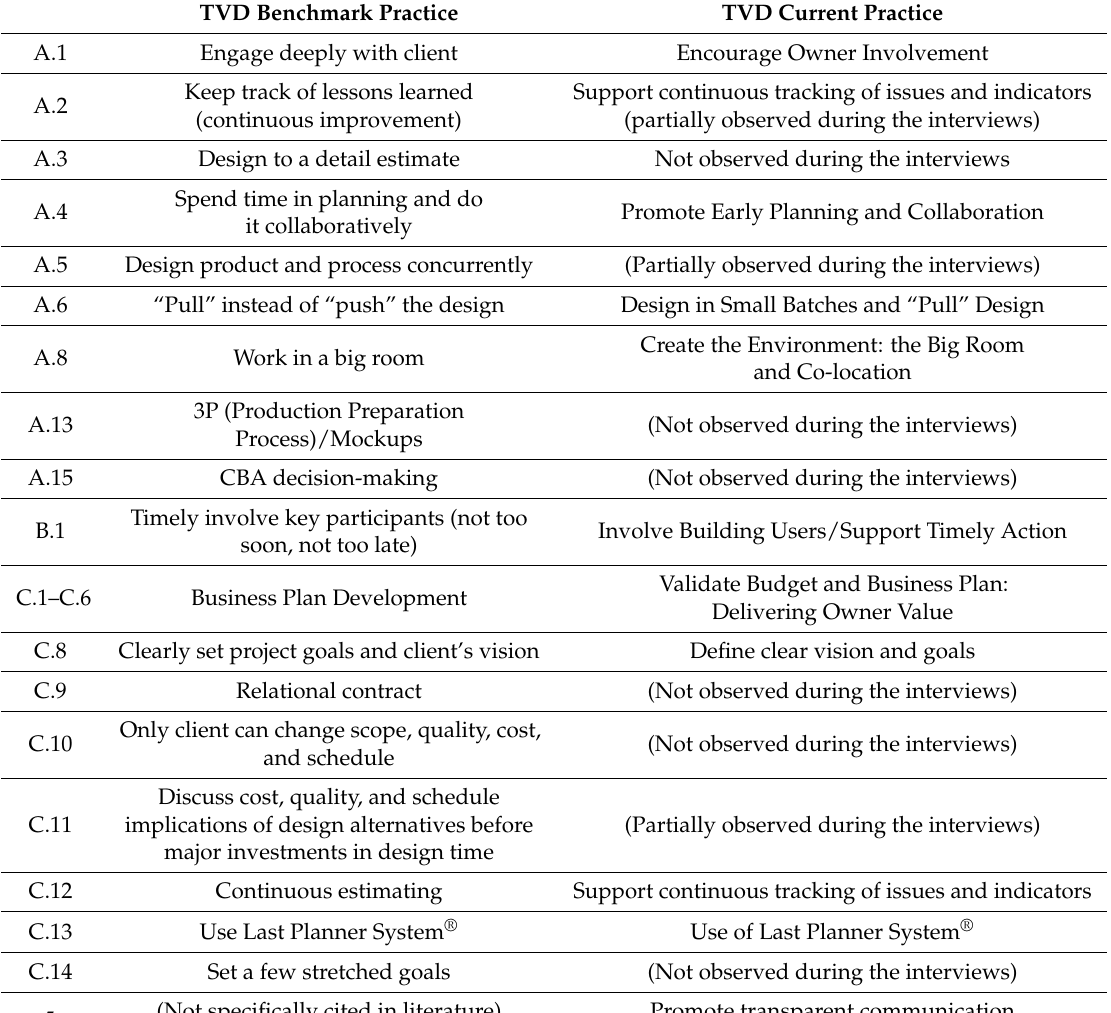
Table 4. TVD Framework: benchmark vs. current